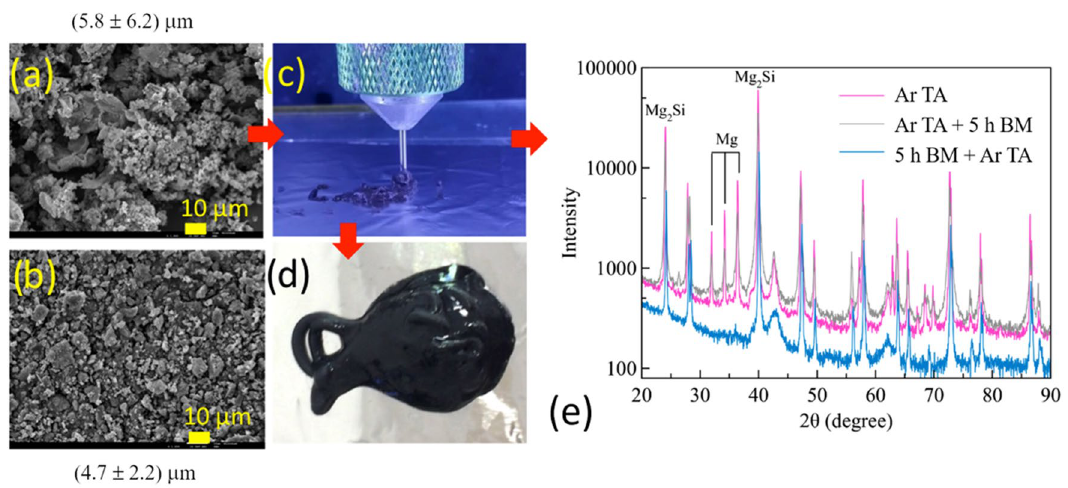
Fig. 3 In the left half: SEM micrographs of Mg 2 Si powders obtained directly by thermal annealing only ( a ) and after the sequence ther- mal annealing and 5 h milling ( b ); photos of extruded Mg 2 Si paste made with powders formed through thermal annealing only ( c ) and close-up ( d ), respectively. In the right half: XRD diffratograms of the